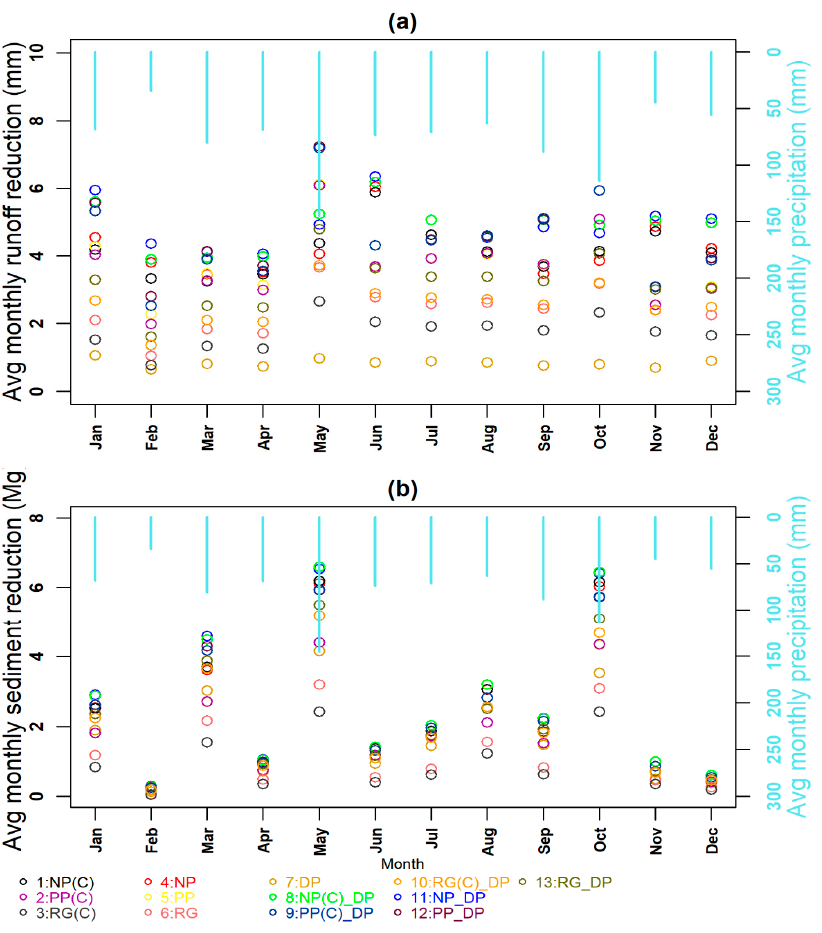
Figure 6. Average monthly ( a ) runoff depth reduction and ( b ) sediment yield reduction at the watershed outlet resulting from LID scenarios from 2005 to 2019. The impacts of three single LIDs (NP, RG, and PP) at hillslope 16 on the daily peak runoff rate, runoff depth, and sediment delivery under the five largest storm events with daily precipitation depths ranging from 106 to 175 mm were plotted (Figure 7). Each LID